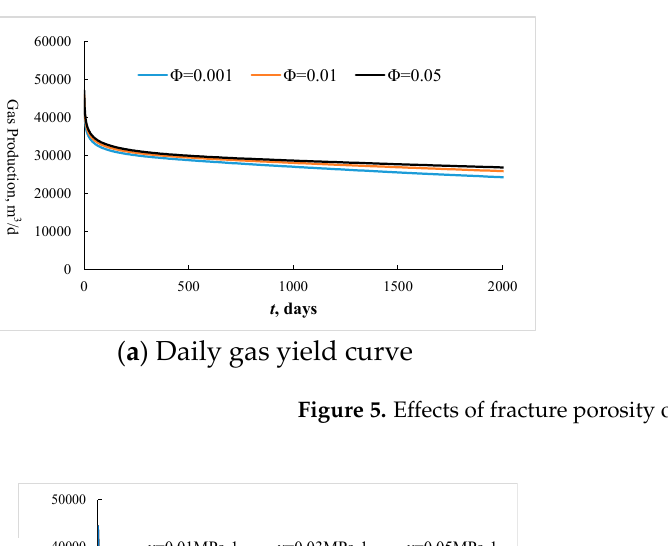
Figure 6. Effects of the stress sensitivity of the fracture on the gas and water production rates.